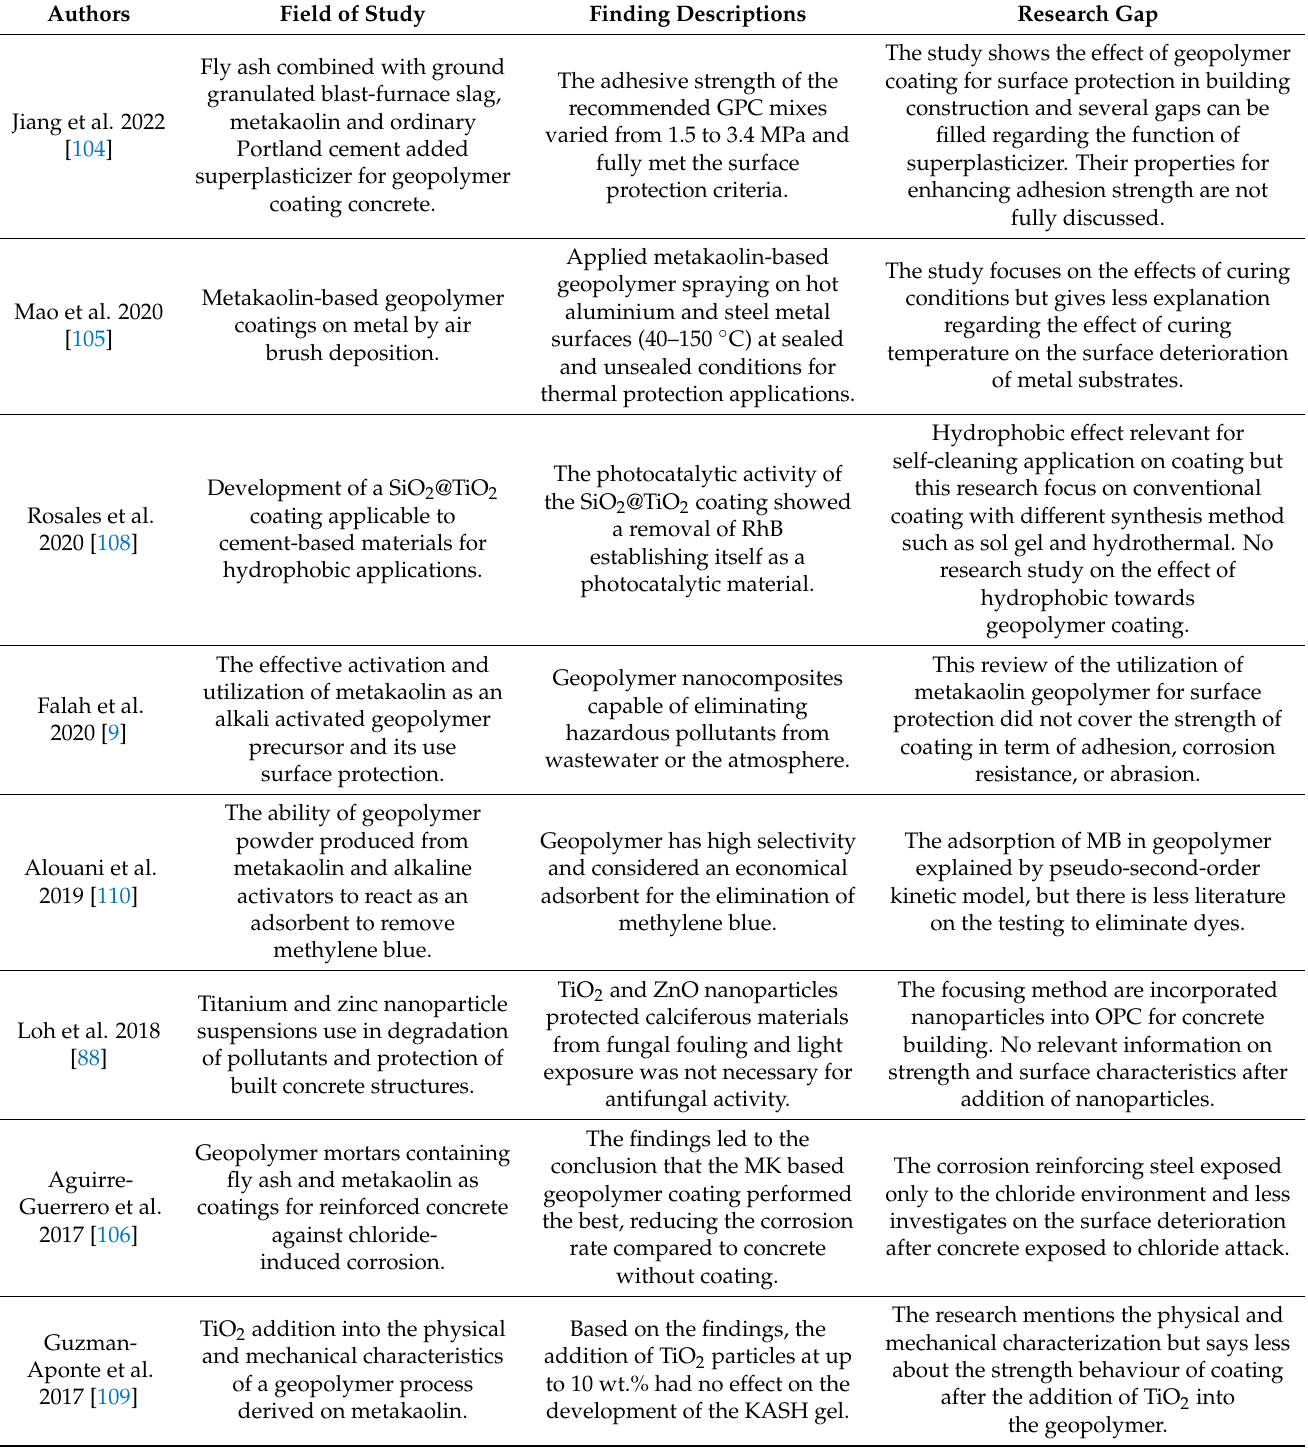
Table 3. Summary of previous research findings in geopolymer